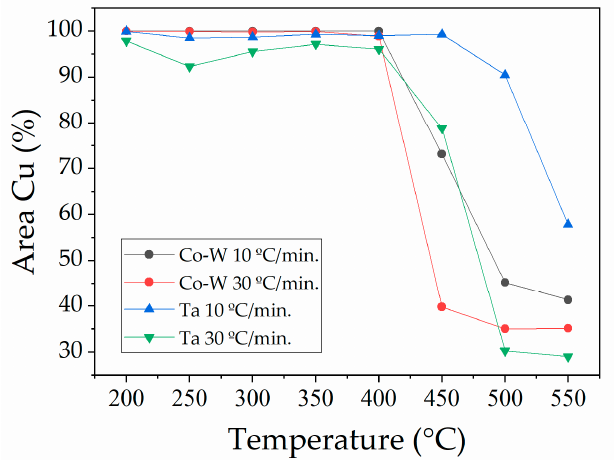
Figure 7. Percentage of sample surface covered by the Cu film as a function of temperature for all studied systems.